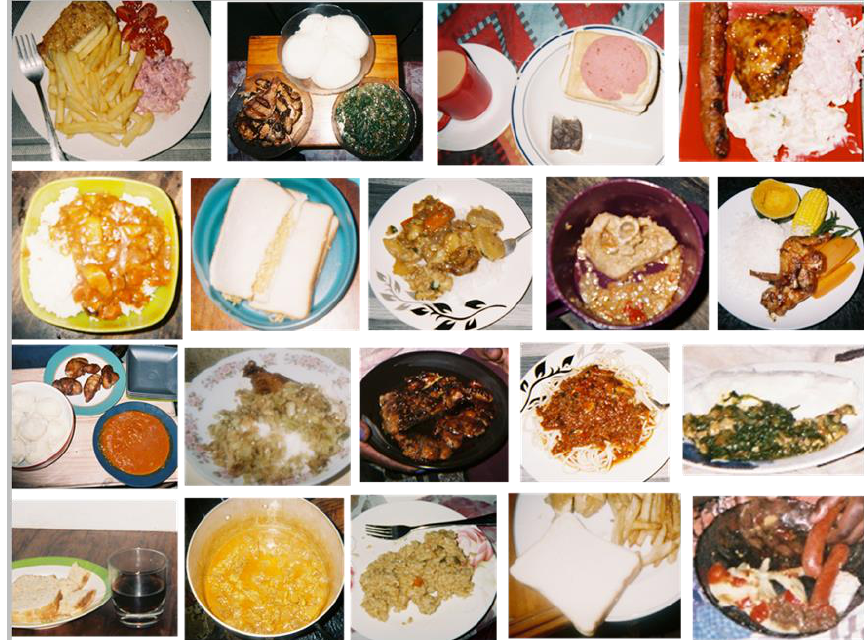
Figure 5. Photographs taken by grade seven learners of meals served in their homes.